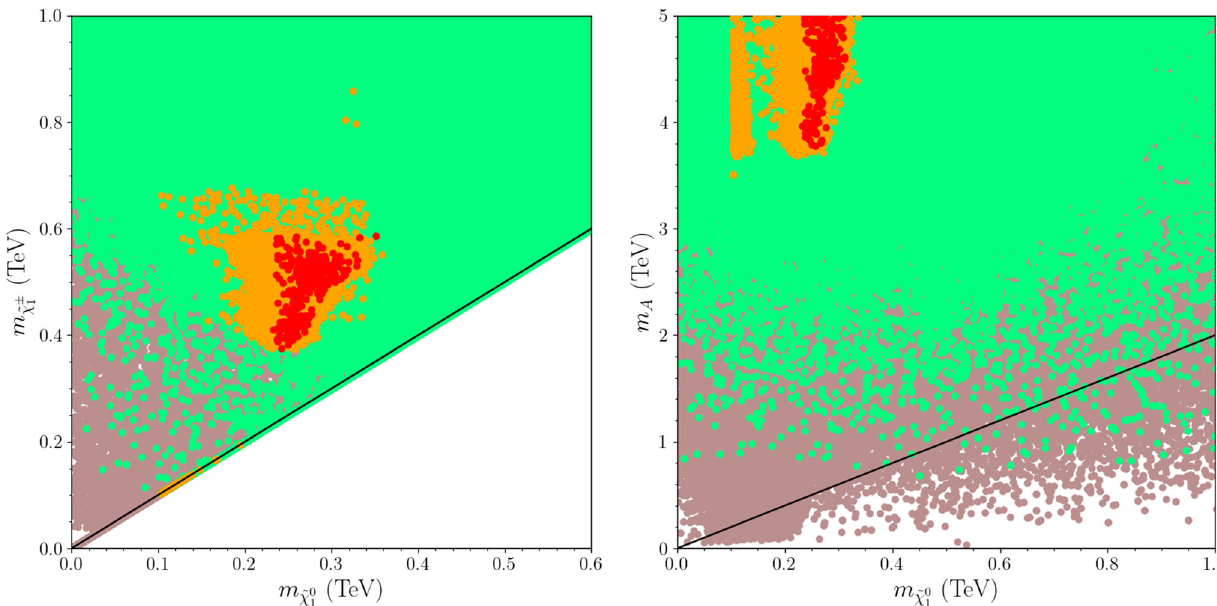
− m m ˜ χ 0 plane represent the bounds from the collider searches on the ˜ χ ± 1 1 chargino–neutralino production with the final states of one lepton-pair of bottom quarks [98], no lepton [99] and a pair of bottom quarks [100], respectively. Each curve can exclude the regions below